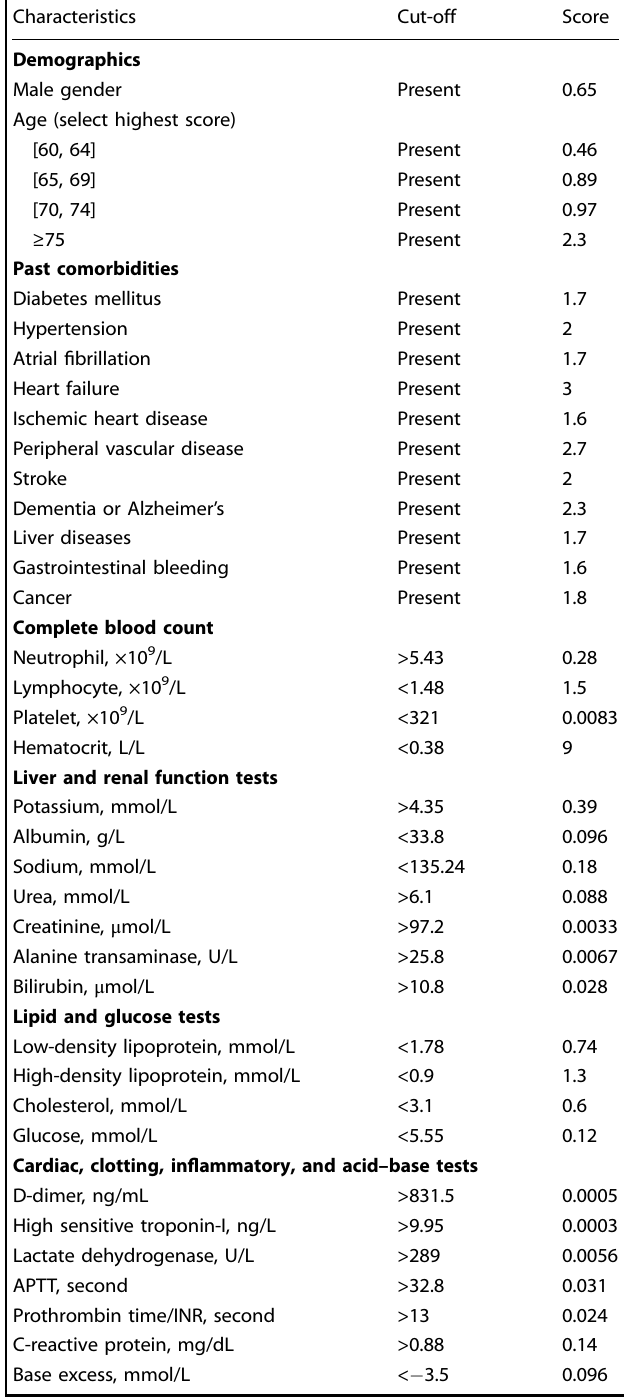
Table 6. Easy-to-use score system for early prediction of severe COVID-19 disease.